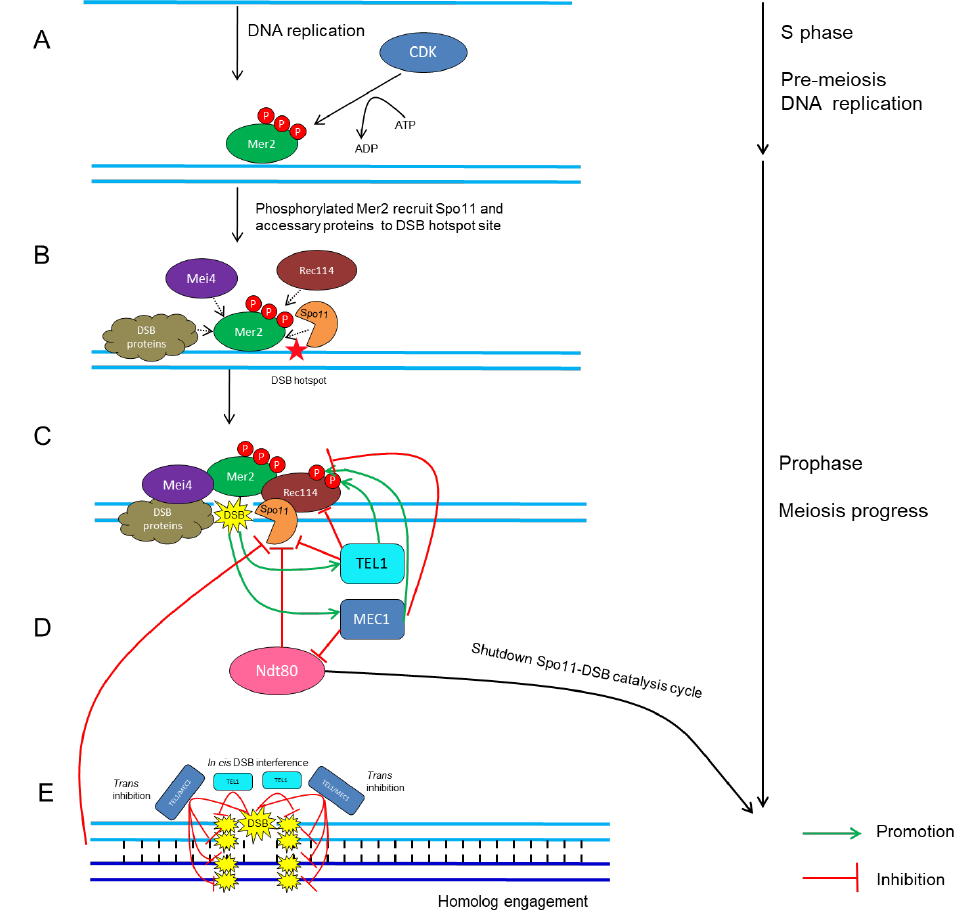
Figure 1. Schematic network of CDK- and ATM/ATR-mediated regulatory cycles of meiotic DSB timing and number in S. cerevisiae . ( A ) CDK phosphorylates Mer2 during pre-meiotic DNA